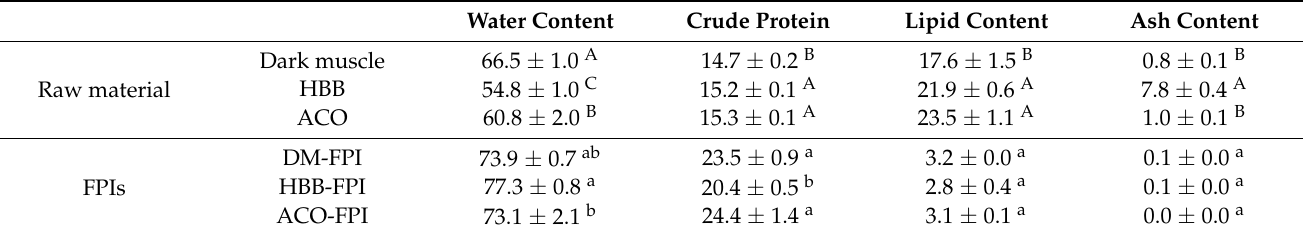
Table 1. Proximate composition (%) of the fish protein isolates (FPIs) produced from Tra catfish dark muscle, head and backbone blend (HBB), and abdominal cut-offs (ACOs) * . Results are expressed as means ± SD from triplicate measurements ( n = 3)